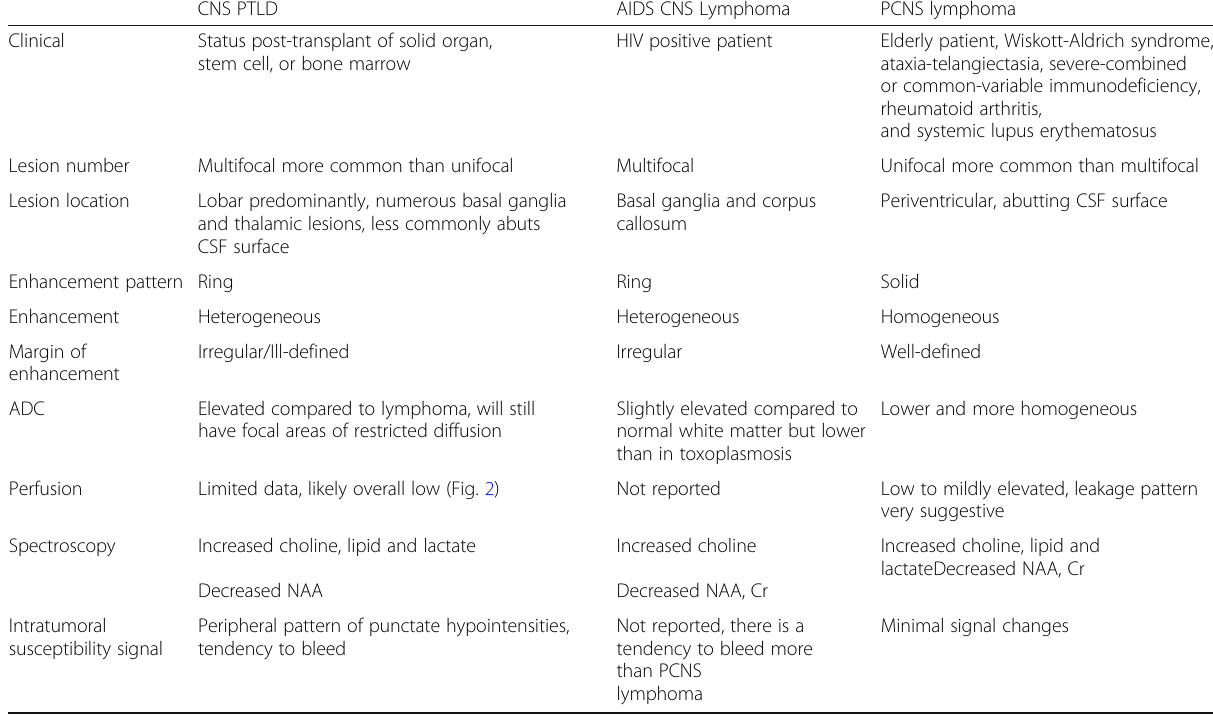
Table 1 MR imaging features CNS PTLD vs AIDS CNS Lymphoma and PCNS